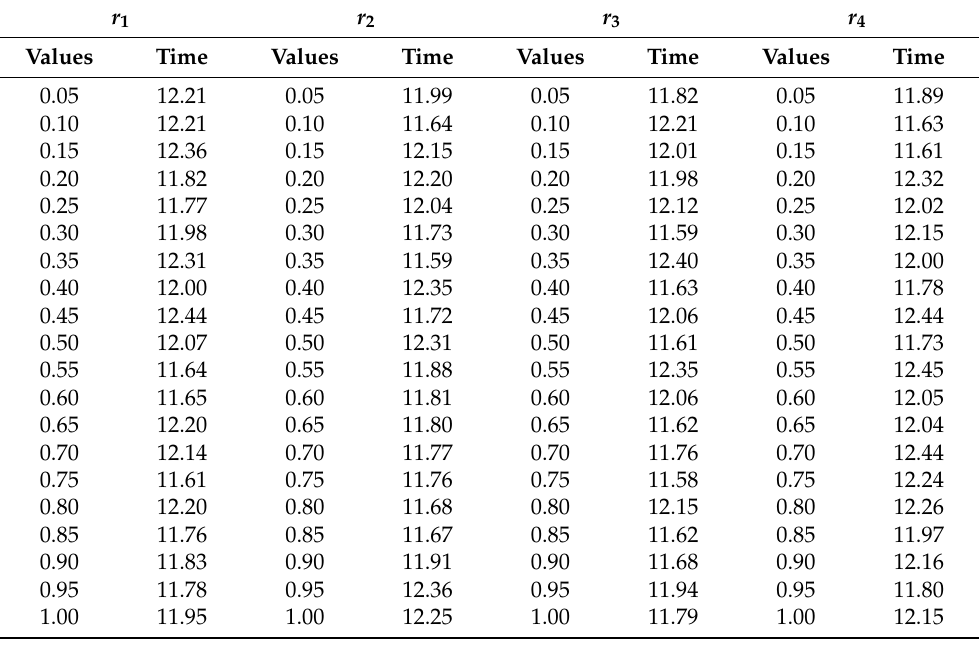
Table 13. Convergence time results (in seconds) for different values of ADSCFGWO’s parameters